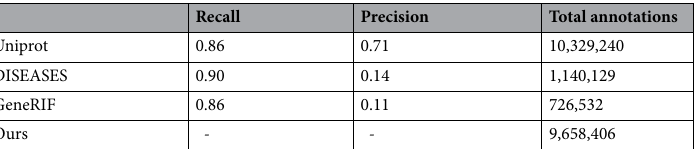
Table 4. Comparison of disambiguation methods. Average recall and precision of the disambiguation of our disambiguation with other databases. Low precision values for DISEASES and GeneRIFs are due to the smaller size of these databases.